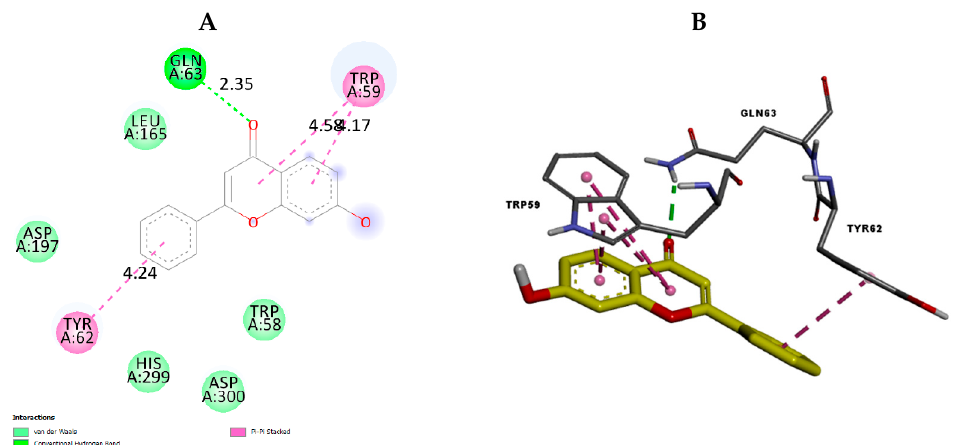
acids of 15-lipoxygenase.